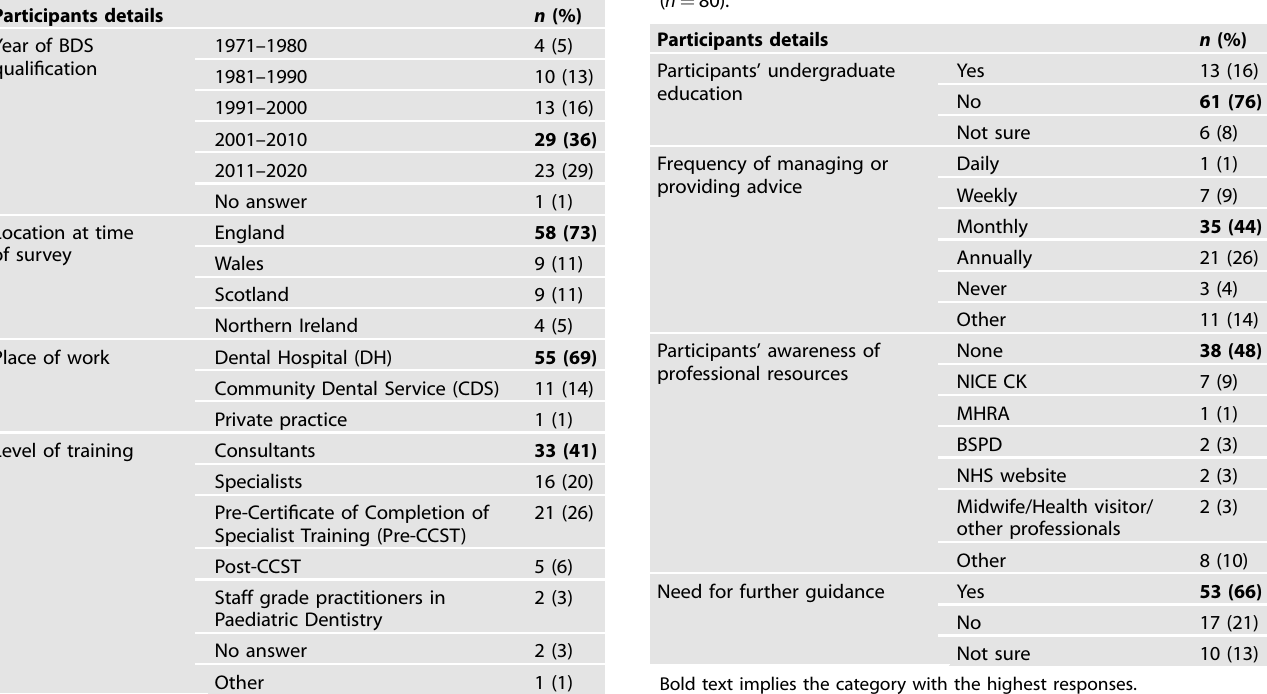
Table 1. Participant characteristics ( n = 80).